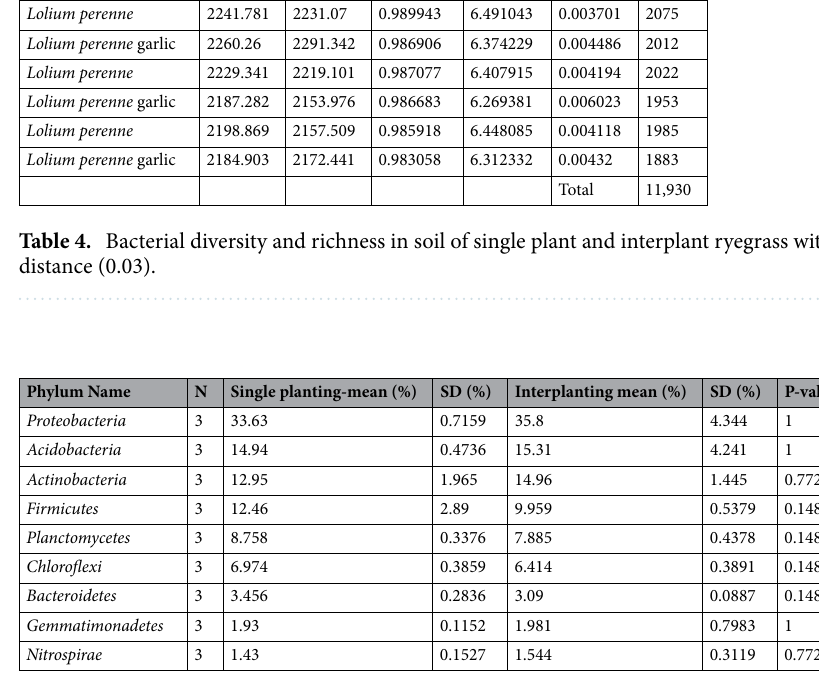
Table 5. Difference in bacteria phyla between the analyzed groups of single planting and cultivated Lolium Perenne with garlic interplanting. The interactive analysis results, Mean is the mean, Sd is the standard deviation; P value is the false positive probability value. N number of plants